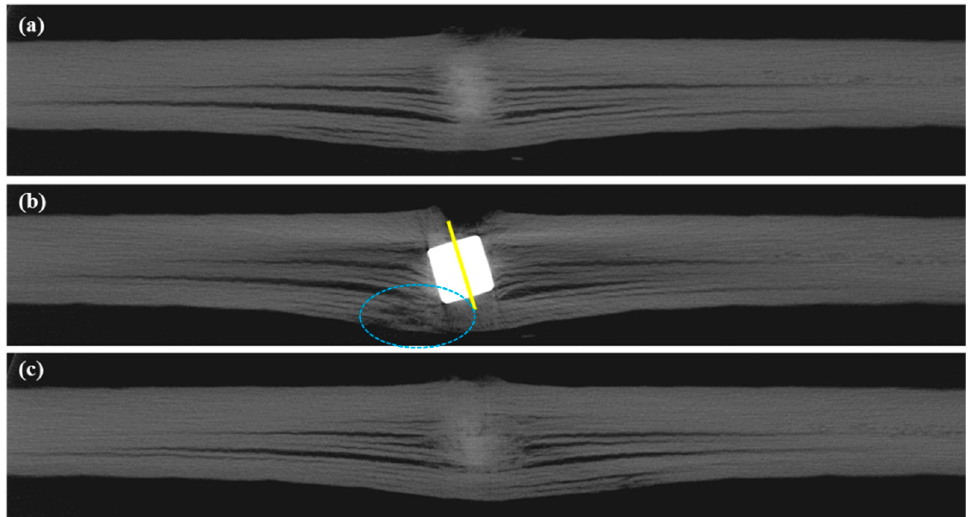
Figure 5. 2D slice images around the impact location of panel P10B. Polymers 2018 , 10 , x FOR PEER REVIEW